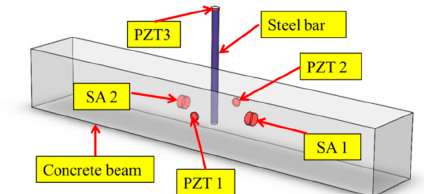
Figure 1. Sketch of the specimen with deployed SAs (lead zirconate titanate smart aggregates) and PZT (lead zirconate titanate) transducers.